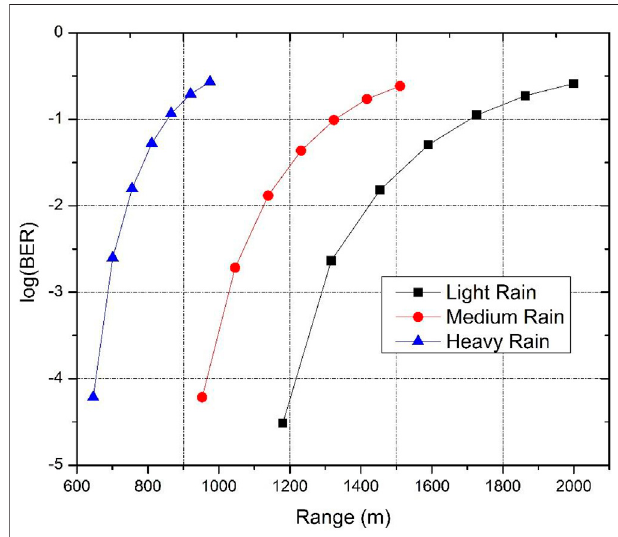
FIGURE3| log(BER)vs. rangeunderCAforOFDM/SAC-OCDMA-FSO.